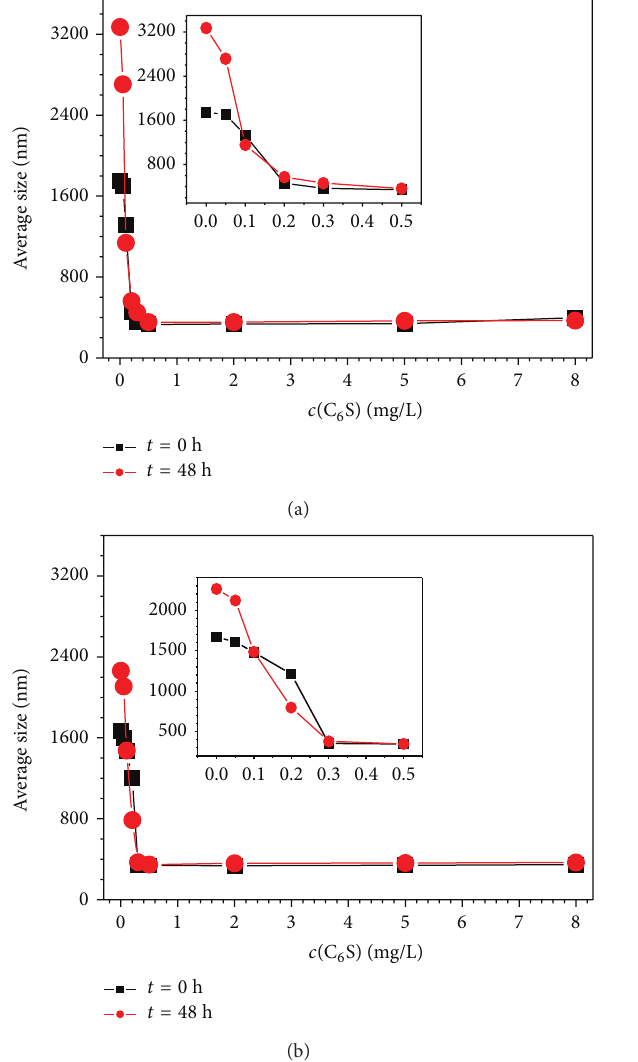
Figure 6: Effect of C 6 S concentration on the average size of submicron COM and COD. (a) COM; (b) COD. Acting time: 0 and 48h.